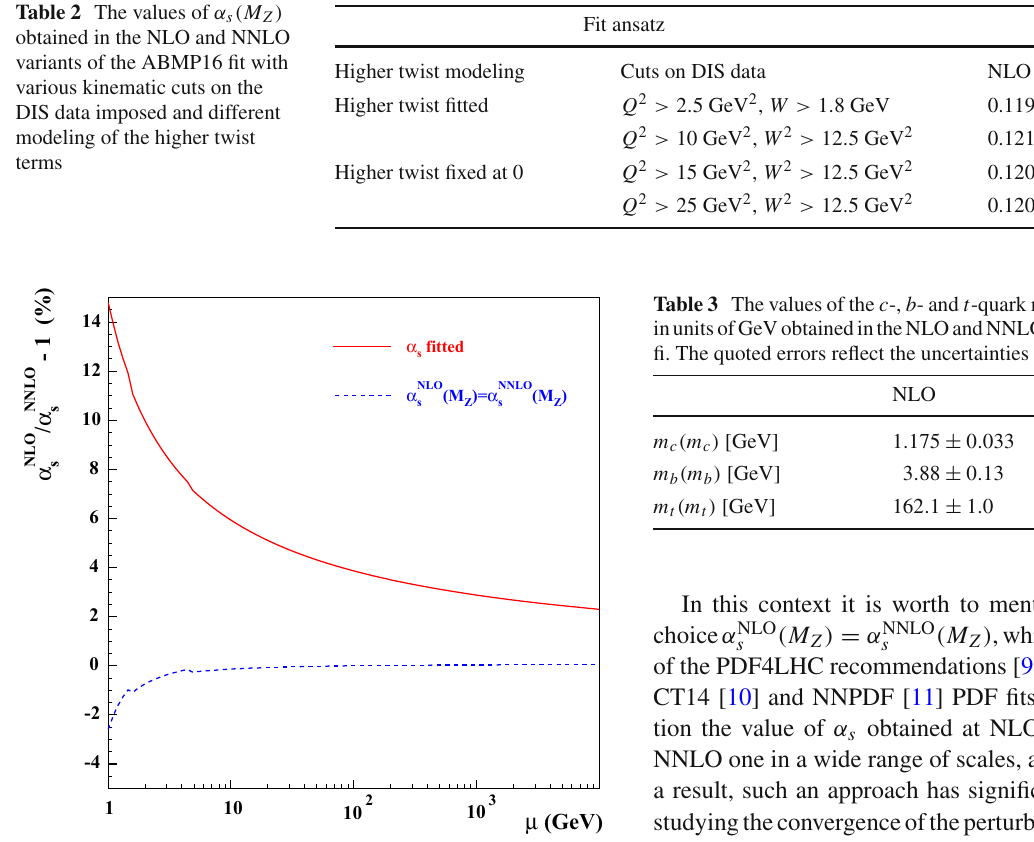
Fig. 2 The relative difference between α NLO s (μ) and α NNLO s (μ) as a functionoftherenormalizationscale μ .Thesolidlinedenotestheresults of the present analysis (NLO) and of Ref. [4] (NNLO), the dashed line displays the ones derived using matching α NLO s = α NNLO s at the scale M Z